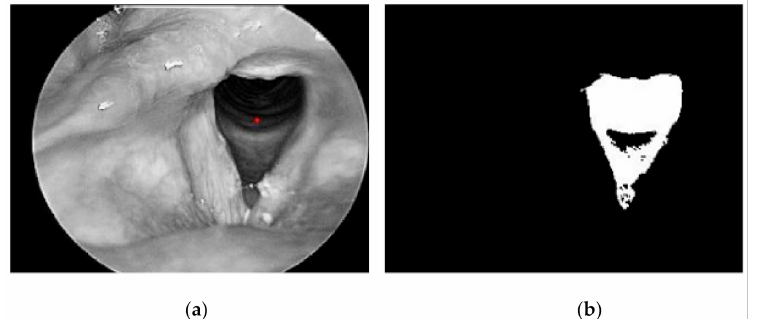
Figure 4. Image of vocal folds ( a ) and corresponding binary image of opening area ( b ) Source: Kuo, C. et al.,